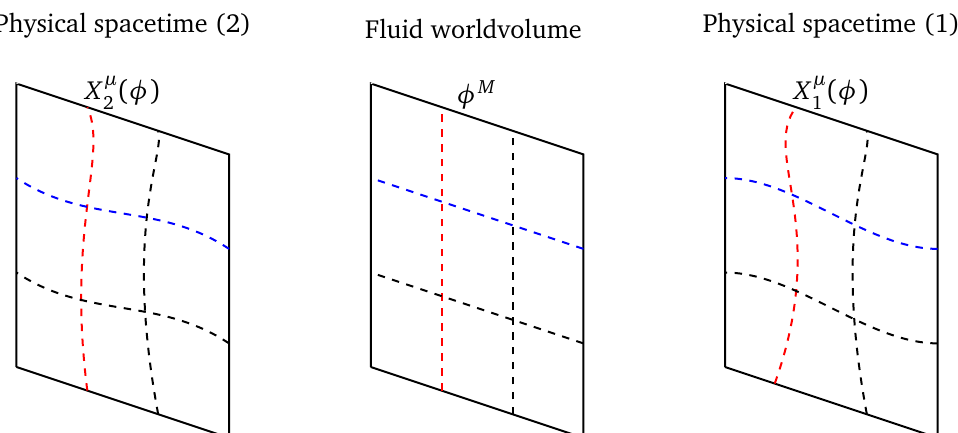
Figure 6: This figure depicts how the fluid world-volume with coordinates φ M is mapped into two copies of the physical spacetime by the maps X The red and blue lines in the right-and left-hand panels are the images of the red and blue lines in the middle panel under the maps X